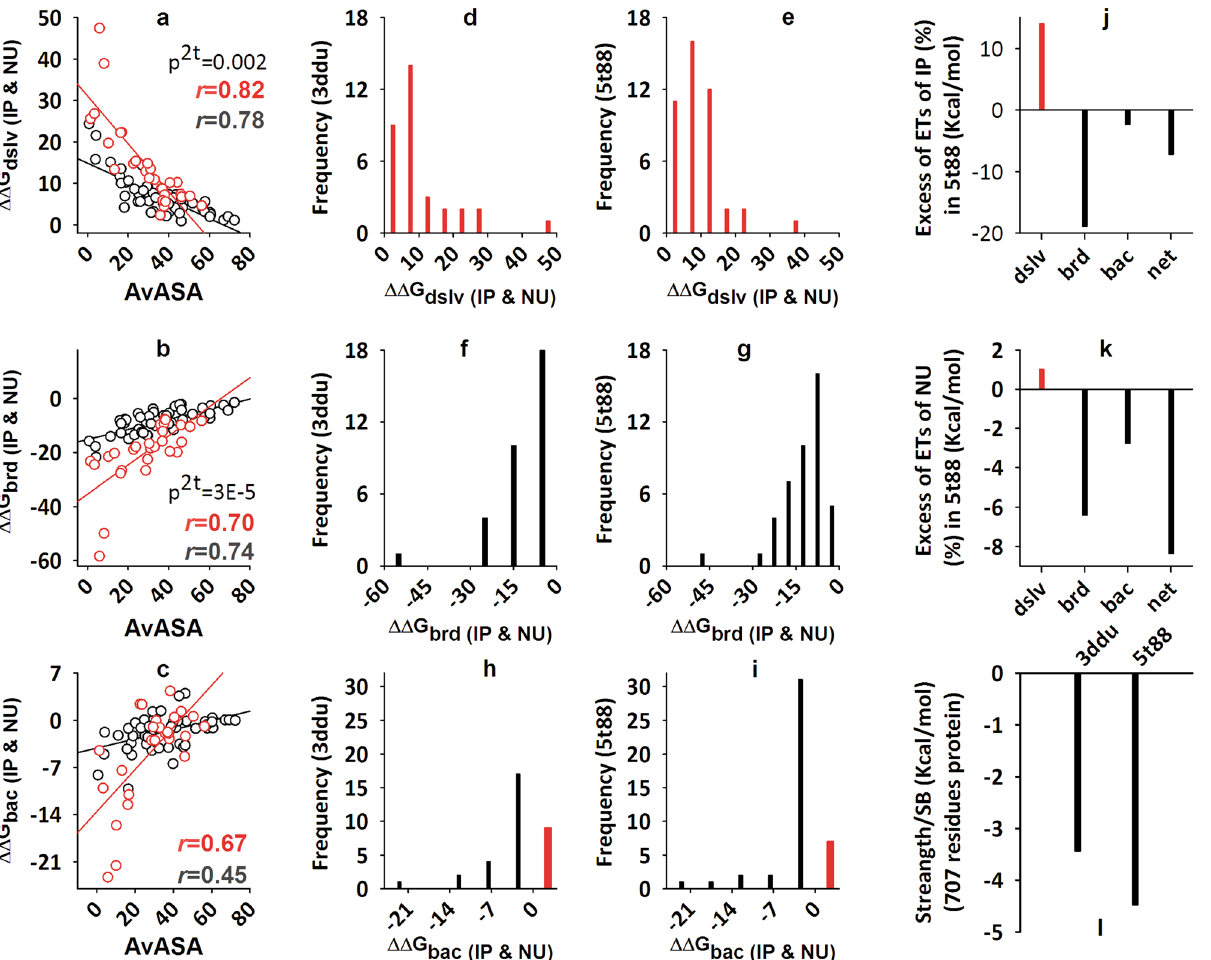
Figure 2. Component and net energy terms for isolated and network types of salt-bridge are more favorable in 5t88 than 3ddu. Correlation plot of ΔΔG dslv ( a ), ΔΔG brd ( b ) and ΔΔG bac ( c ) with ASAav for IP (black) and NU (red) salt-bridges (p 2t is 2tailed probability for a test of significance). Distribution of 5t88 and